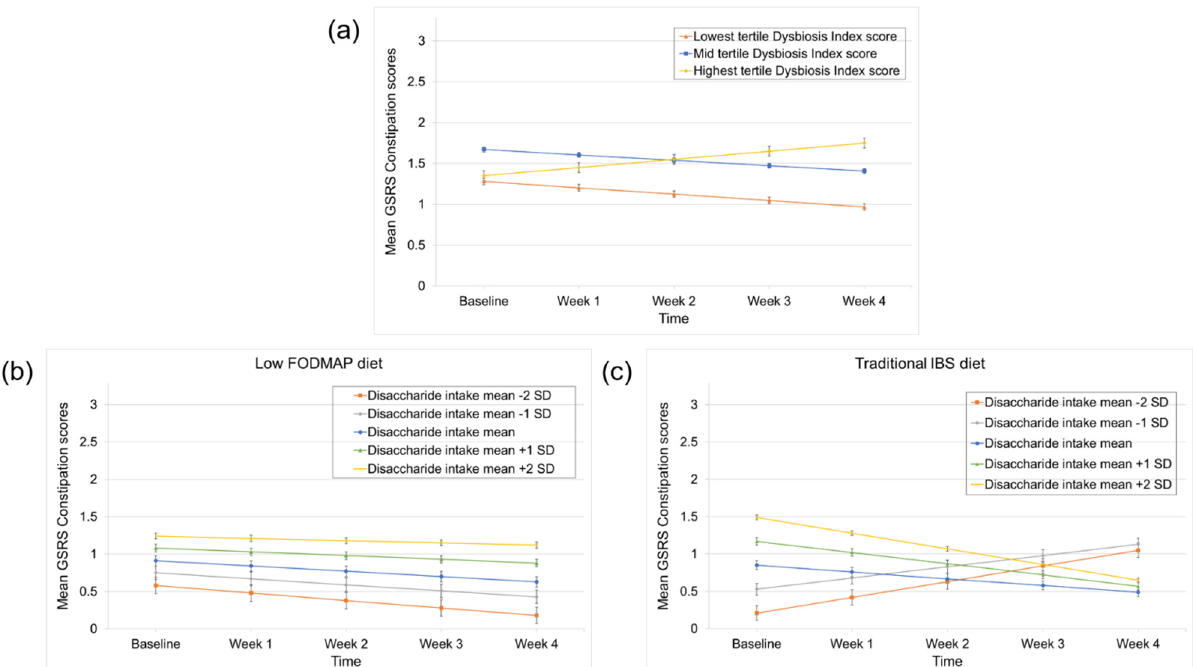
Figure 3. Predictors of constipation improvement during the low FODMAP and traditional IBS diet. ( a ) A lower Dysbiosis Index score predicted better response to both diets. ( b ) Disaccharide intake was a differential predictor with a non-significant association between higher baseline disaccharide intake and a worse response in low FODMAP treatment arm and ( c ) a significant association between higher baseline disaccharide intake and a better response in traditional IBS treatment arm. The GSRS-IBS subscales used in the linear mixed (i.e., random-effect) models were BoxCox transformed. For the transformation of the constipation subscale, the following BoxCox formula was used: y ( λ ) = y This led to changes in the original score range score of 1–7 to 0–3.29, using the formula: y ( 0.5 ) = y .